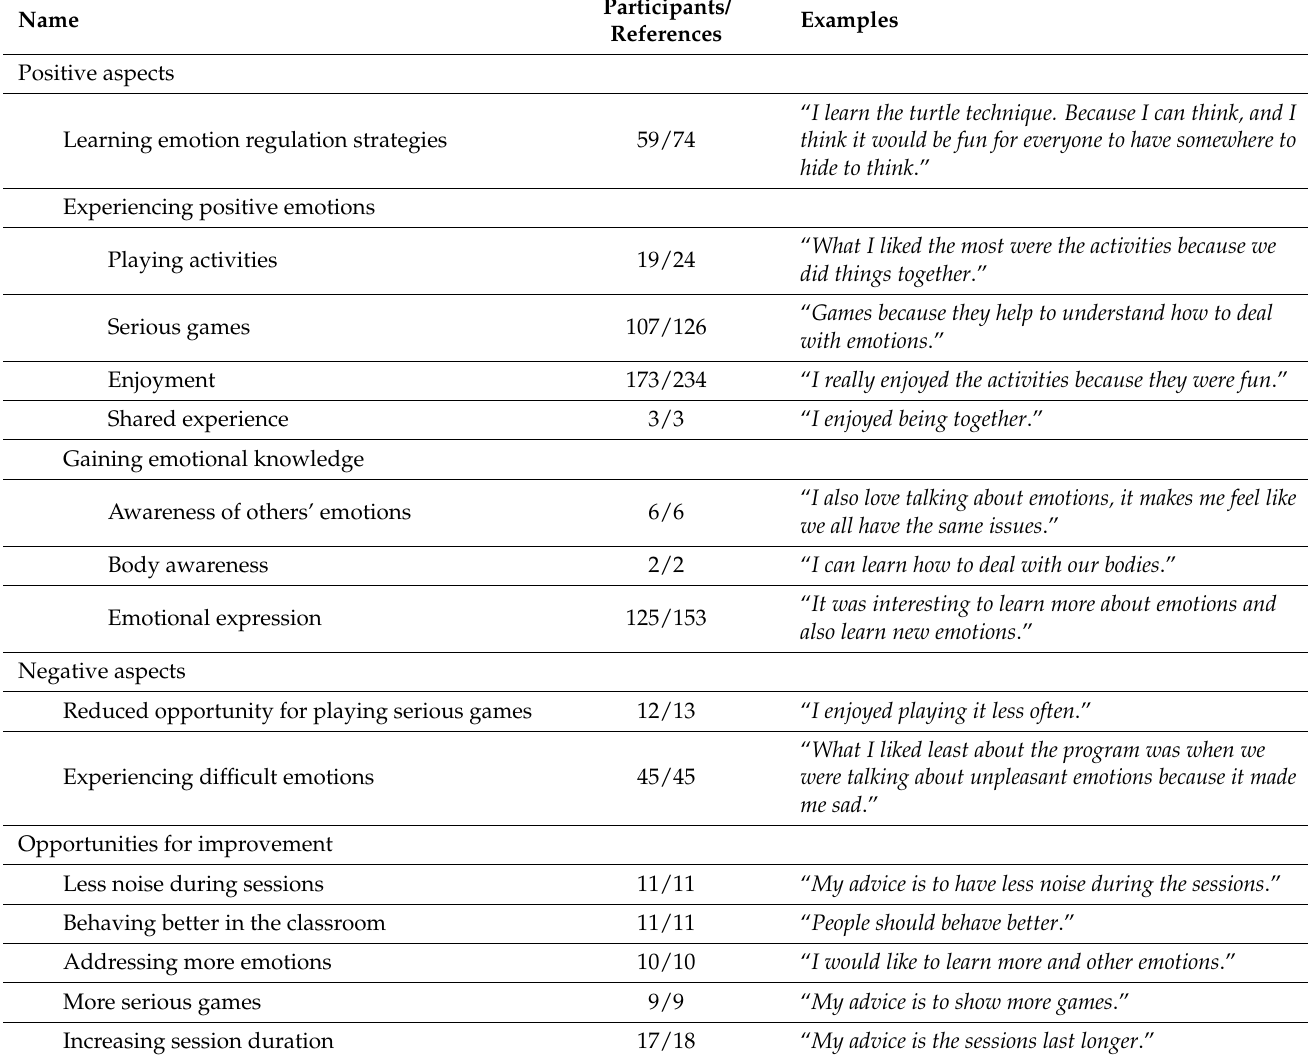
Table 2. Number of participants and references in each sub-themes and examples (N = 221